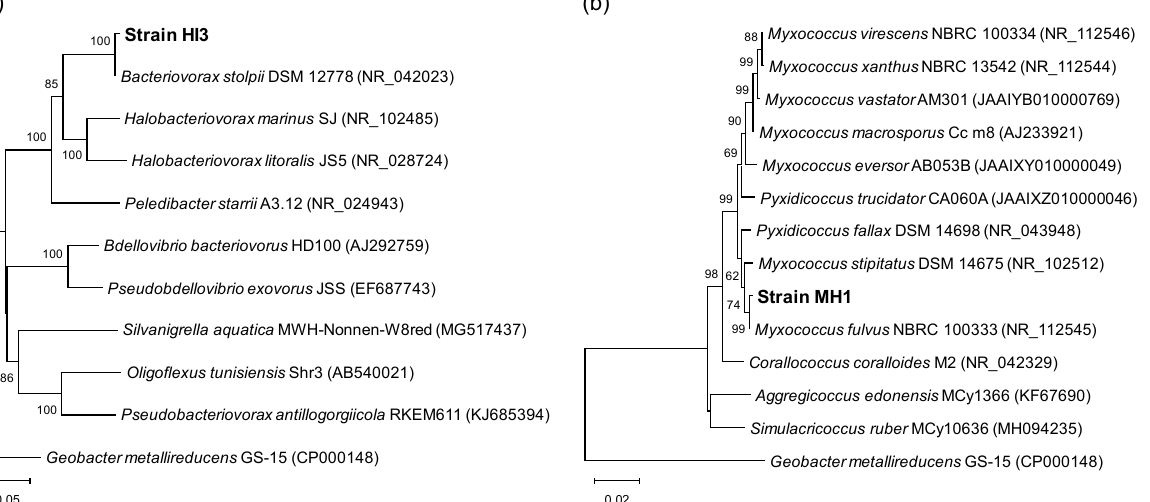
Figure 1. Phylogenetic tree based on 16S rRNA gene sequences from isolated predatory strains HI3 ( a ) and MH1 ( b ) and the type strains of their related genera. Evolutionary relationship was inferred using neighbor-joining method, with Kimura 2-parameter model. Geobacter metallireducens GS-15 T was used as an outgroup. Accession numbers of nucleotide sequences for type strains are provided in parentheses. Bootstrap values >50% based on 1000 replicates are shown at nodes. Scale bar represents 0.05 ( a ) or 0.02 ( b ) nucleotide substitution per site.